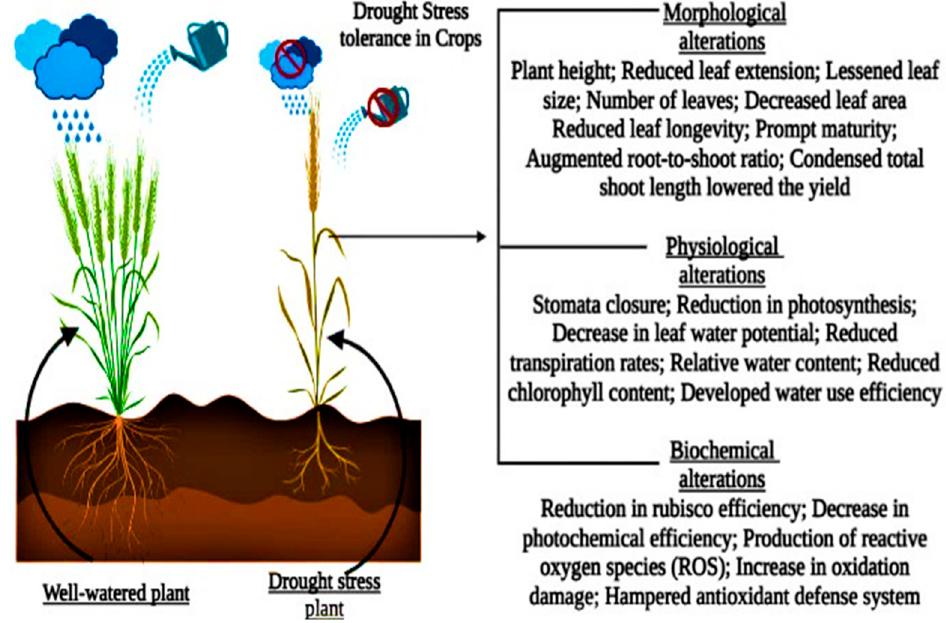
Figure 2. Drought stress impacts plants’ morphological, physiological, and biochemical